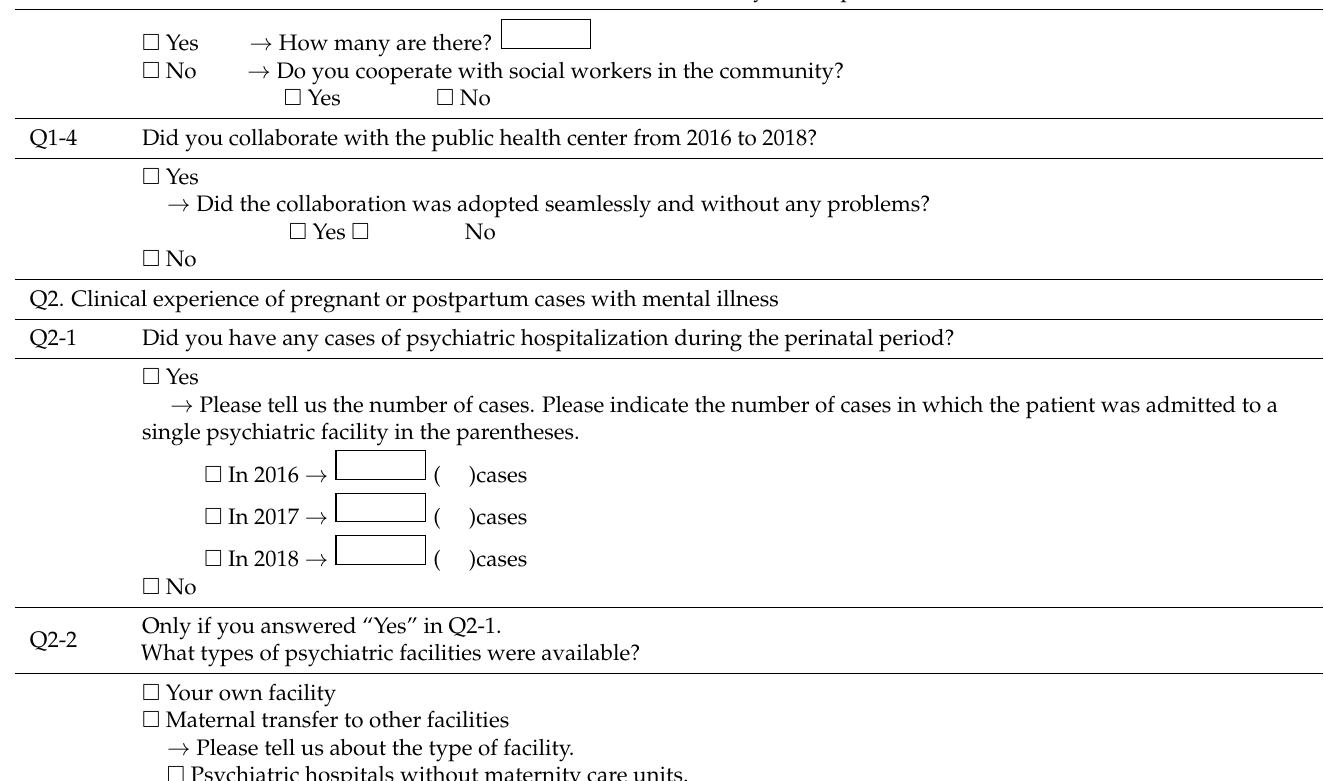
Table A1. Questionnaire for maternity care units.